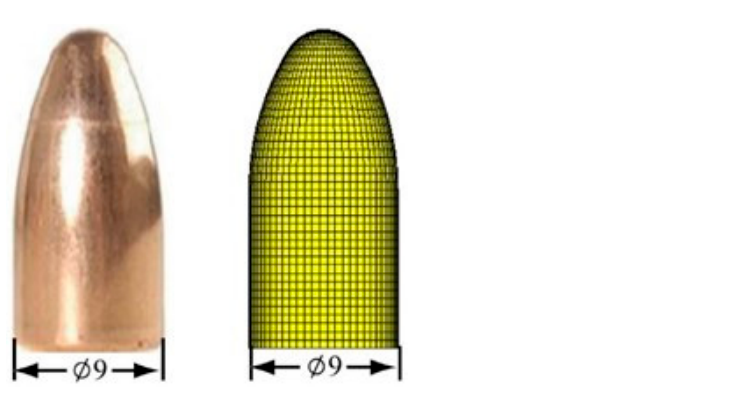
Figure 2. Woven and UD fabric laminate with ballistic impact. (Adapted with copyright permission from Cavallaro et al. [17]).